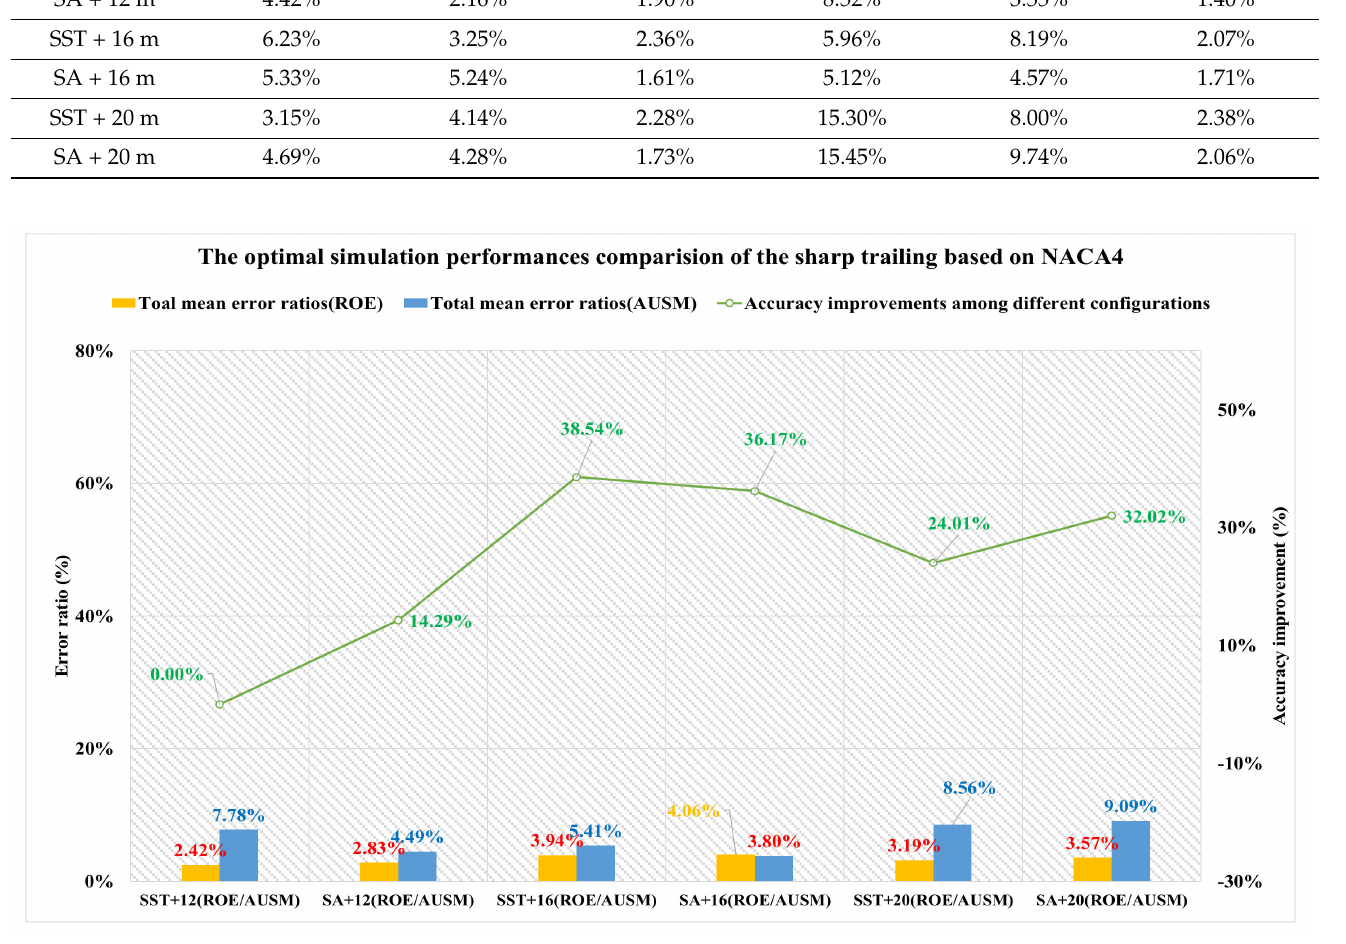
Figure 10. Comparison of the simulation performances of the sharp trailing edge based on NACA4 under different simulation